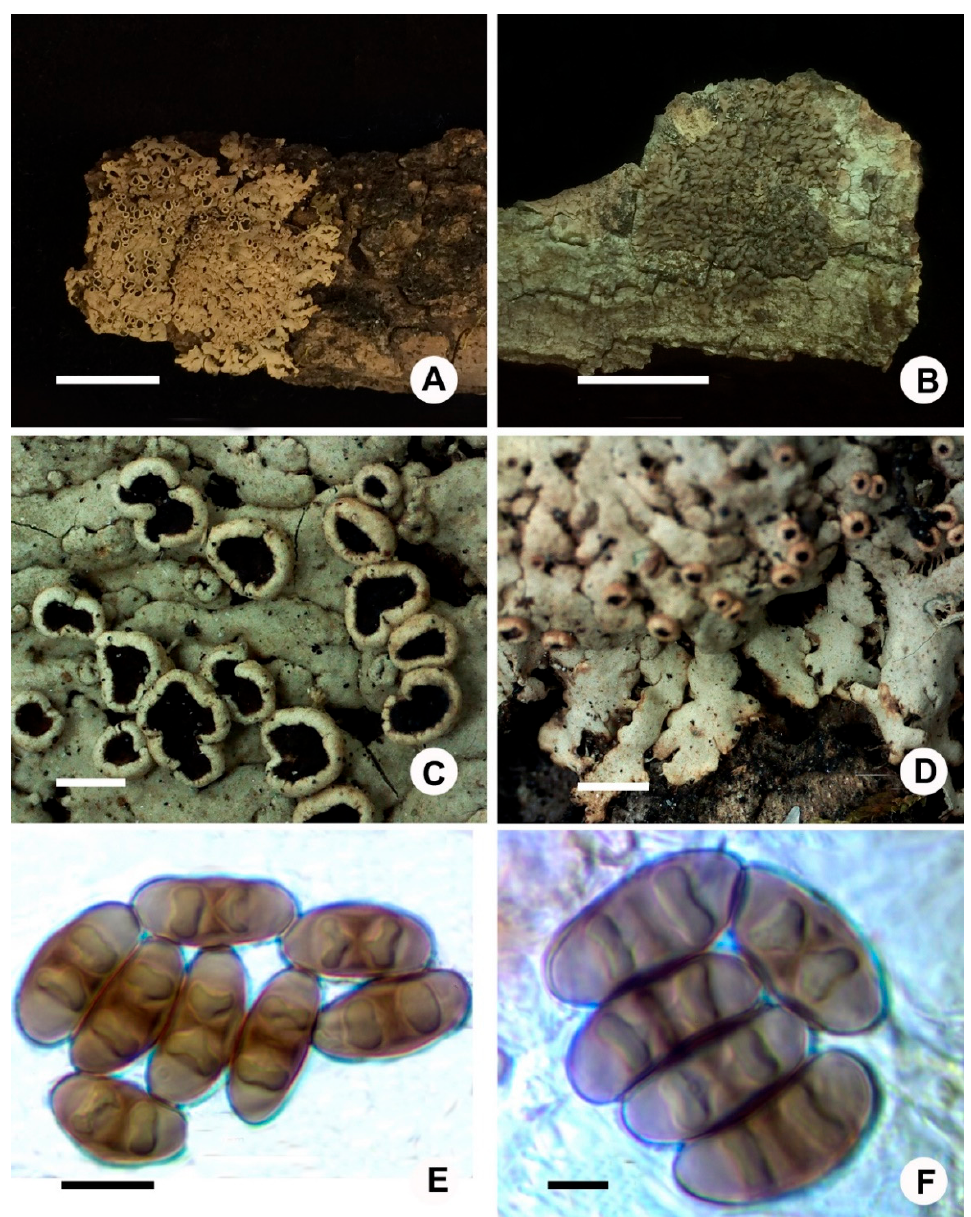
Figure 3. New records: ( A , C – E ), Phaeophyscia leana (J.S. Hur 040554), ( A ) habitat, ( B ) Phaeophyscia hunana (121894), ( C ) apothecia, ( D ) lobes, and ( E , F ) ascospores in oil. Scale bars: A,B = 1 cm, C,D = 1 mm, E = 10 µm, F = 5 µm.